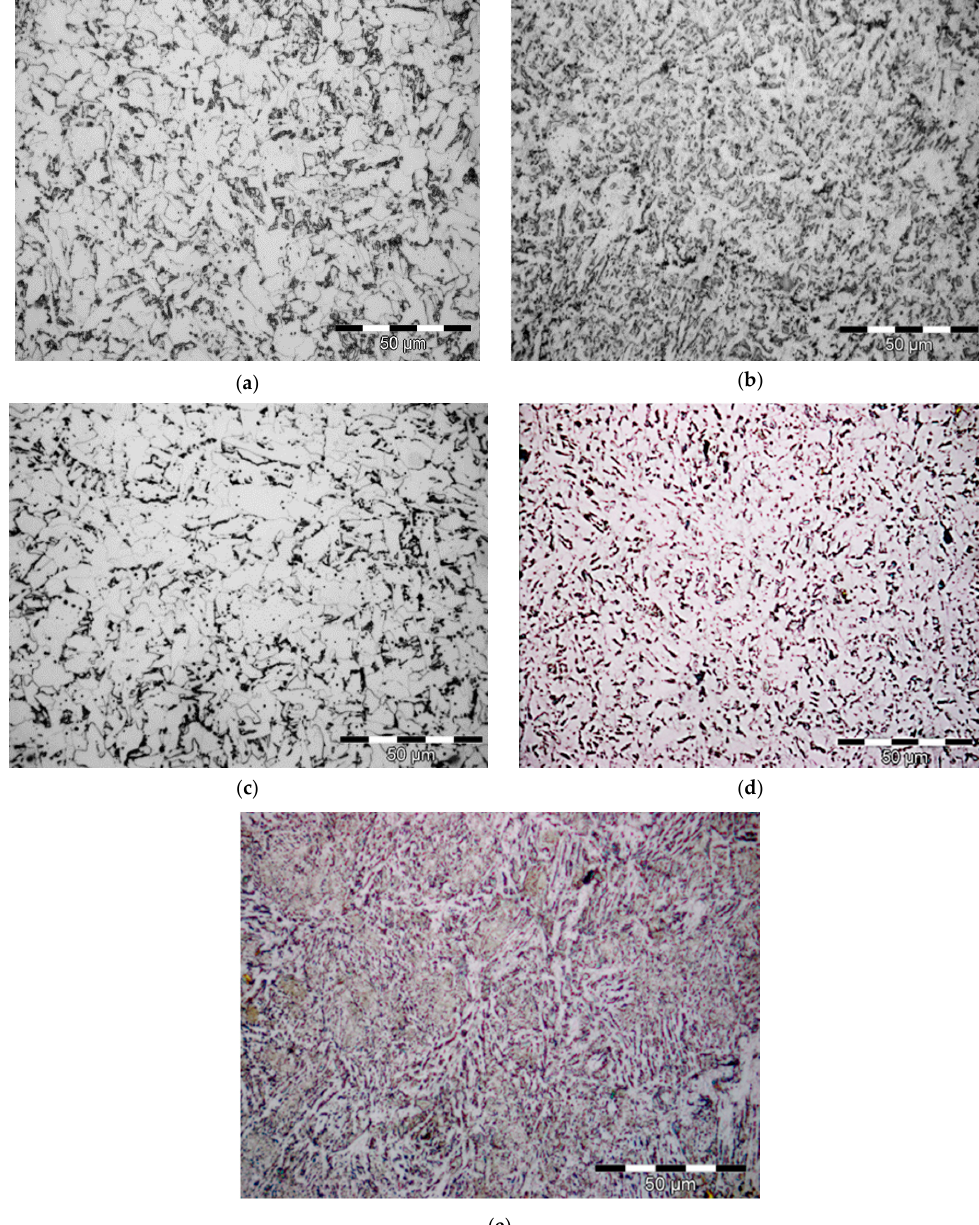
Figure 7. Microstructure of the HAZ material: ( a )—sample S1; ( b )—sample S7; (c)—sample S10; ( d )—sample S11; ( e )—sample S16.